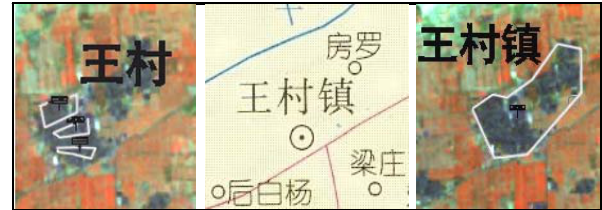
Figure 6. Habitation updating with comprehensive utilization of multi-source